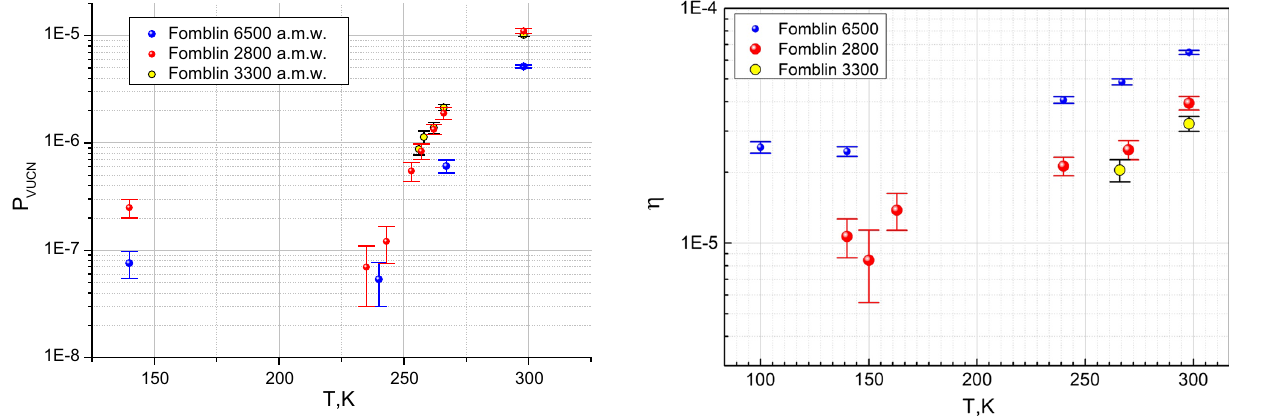
“gamma-functions” were calculated for the average neutron energy corresponding to the height of 30 cm: γ sample = 13 . 0 s − 1 , γ sp = 7 . 4 s − 1 .